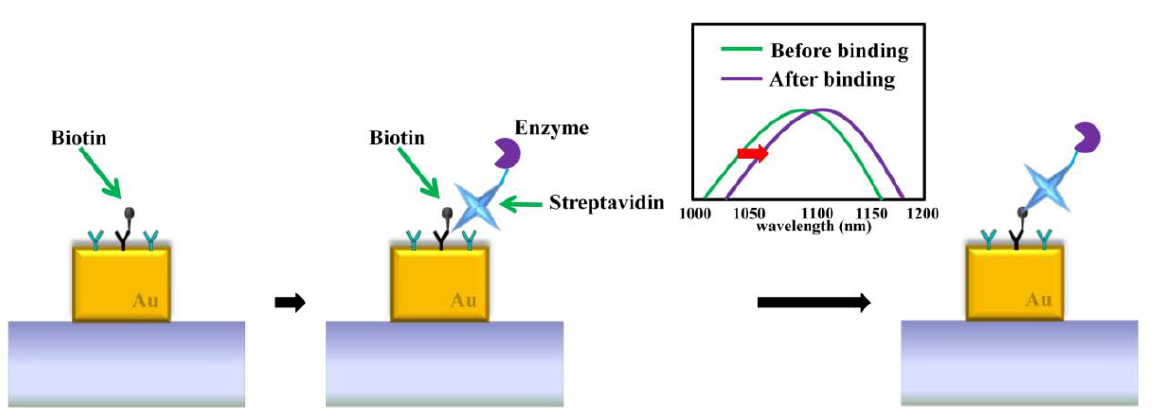
Figure 14. Detection of protein-protein binding event on the gold nanostructure through LSPR peak